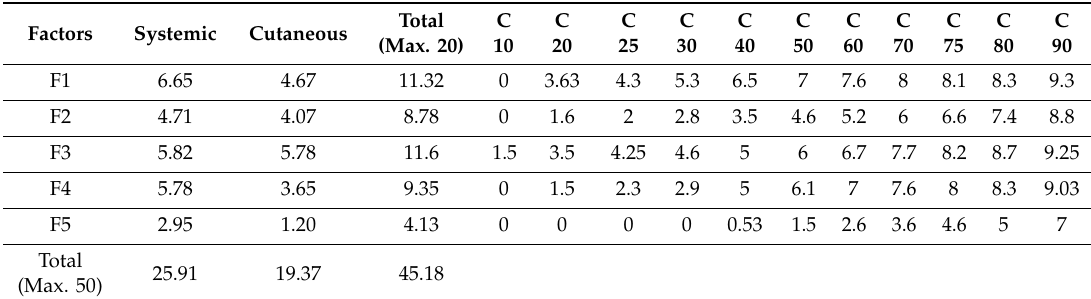
Table 4. Percentiles of LEQoL